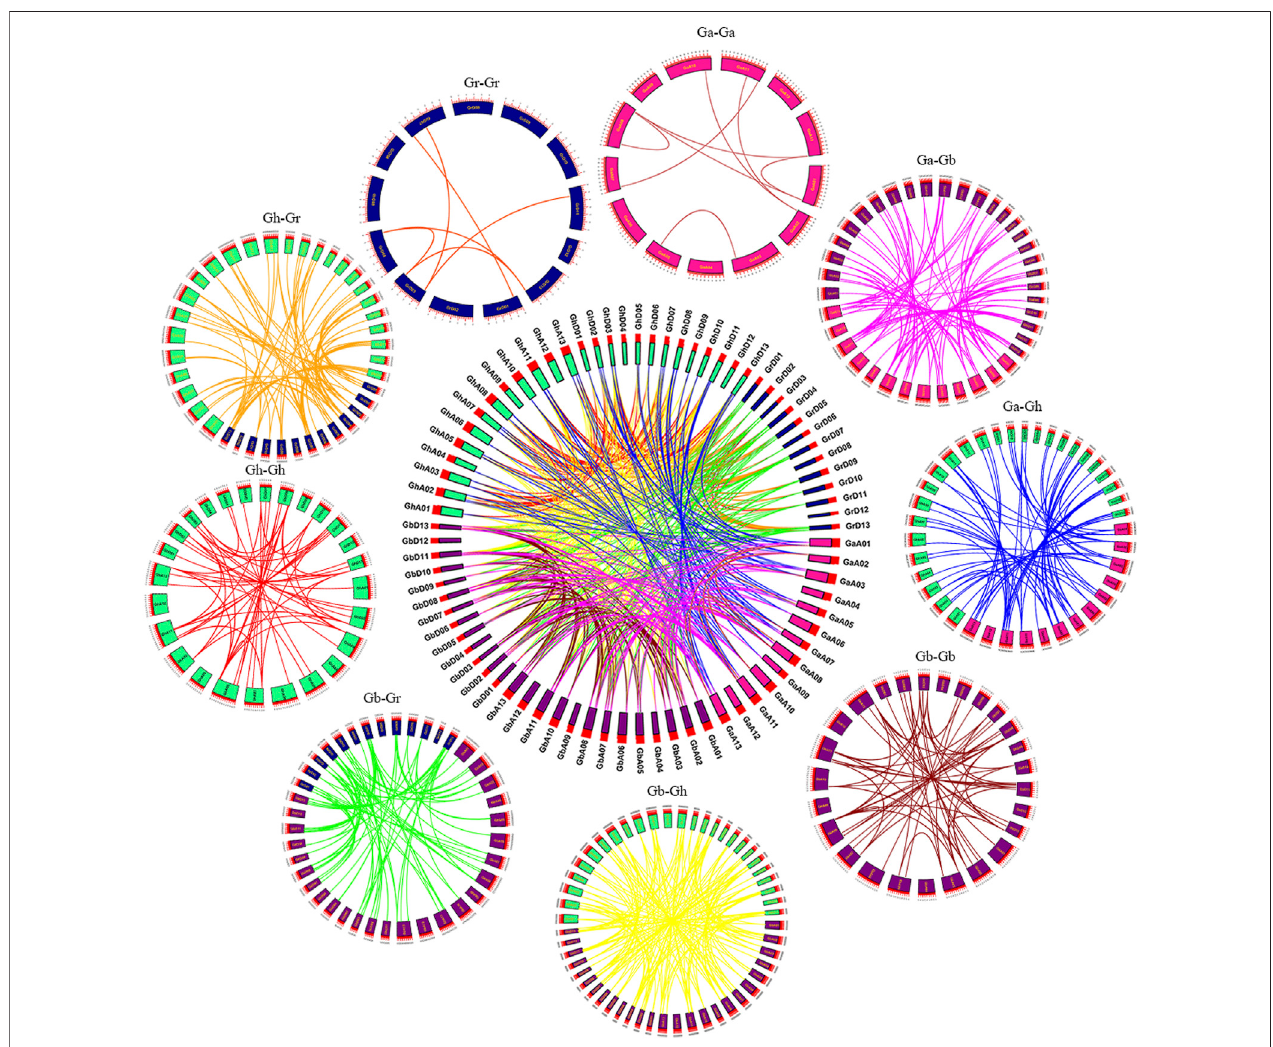
FIGURE 5 | Syntenic relationship of duplicated genes pairs from four cotton species ( G. hirsutum , G. barbadense , G. arboreum and G. raimondii ). The chromosomal lines in different colors indicate the collinearity area around the SNAT genes.